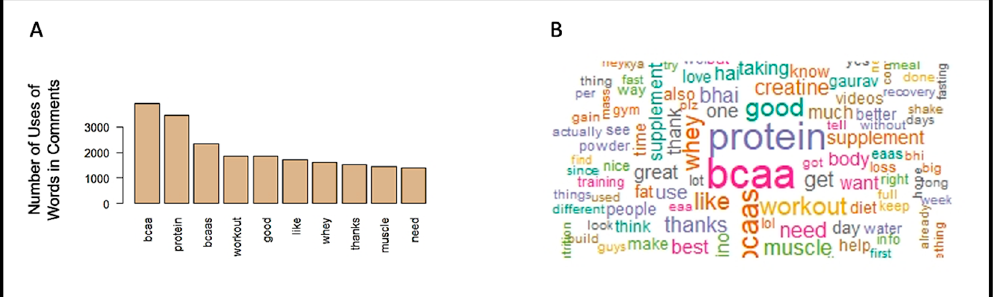
Figure 3. ( A ) Number of uses of words in comments. ( B ) Word cloud of most-often used words in comments.